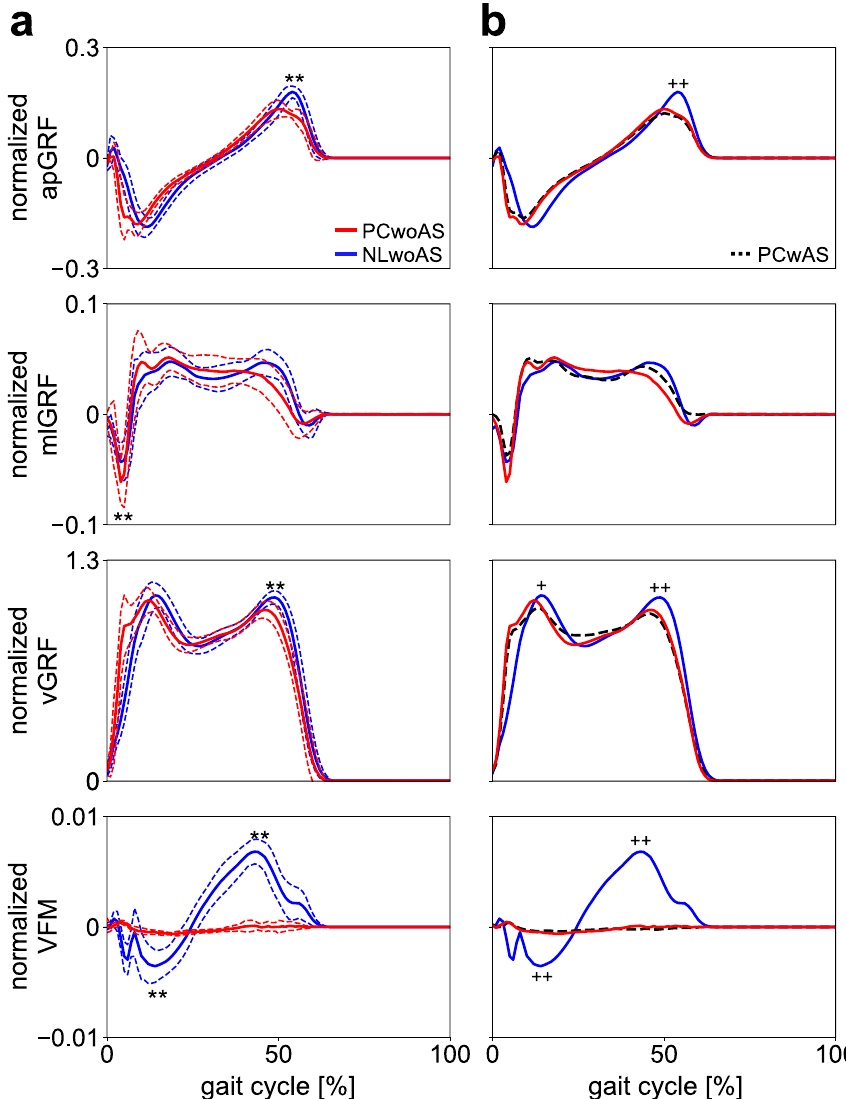
Figure 2. Mean normalised GRF and VFM profiles during walking with NL and PC shoes when arm swing was restrained (NLwoAS and PCwoAS, respectively) ( a ). Mean normalised GRF and VFM profiles were also compared with those using the PC shoes when the arm swing was not restrained (PCwAS) ( b ). Blue solid line = NLwoAS, Red solid line = PCwoAS. Corresponding dashed lines represent standard deviations. Black dashed line = PCwAS. Asterisks indicate statistical differences of the maximum or minimum values between NLwoAS and PCwoAS (*: p < 0.05. **: p < 0.01). Pluses indicate statistical differences between NLwoAS and PCwAS (+: p < 0.05. ++: p <